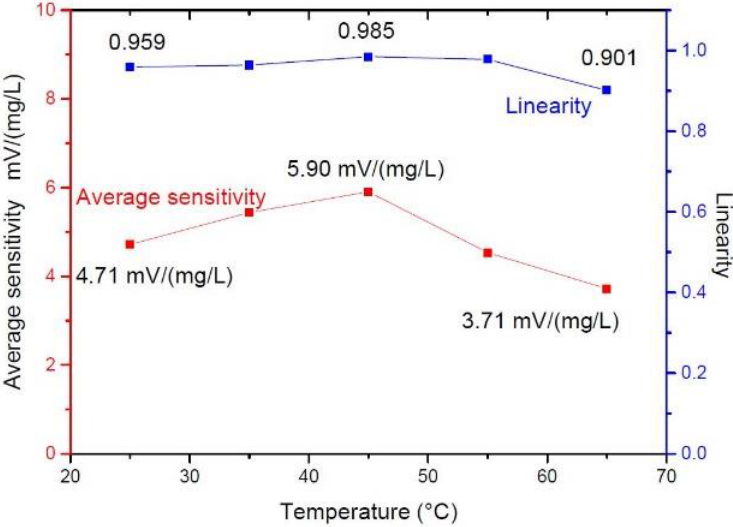
Figure 13. Temperature effects of the AgNW – uricase/rGO/NiO uric acid biosensor in the temperature range of 25 – 65 °C. Table 2. Average sensitivity and linearity of the uric acid biosensor based on AgNW – uricase/rGO/NiO film in the tem- perature range of 25 – 65 °C.